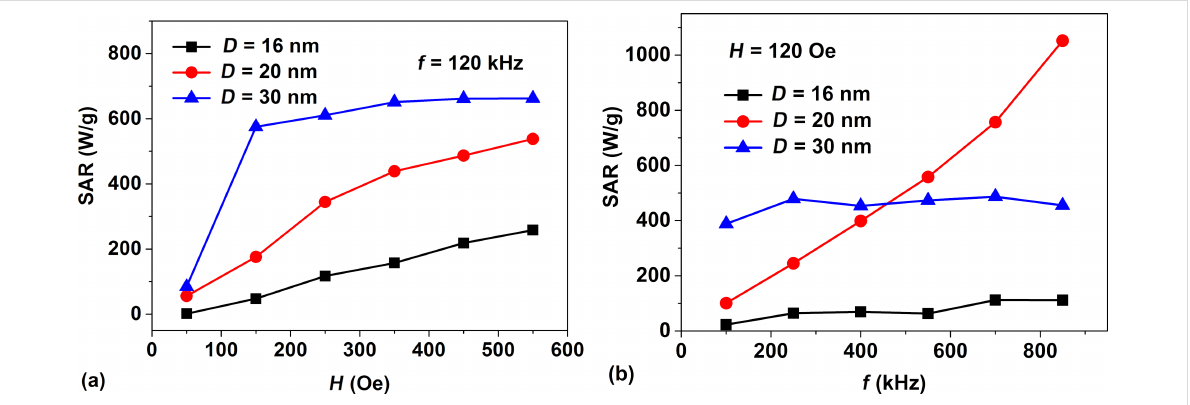
Figure 7: a) SAR of a dilute assembly of iron oxide nanoparticles of different diameters at a fixed frequency, f = 120 kHz, depending on the RMF amplitude; b) the same for a fixed RMF amplitude, H 0 = 120 Oe, depending on the field frequency.